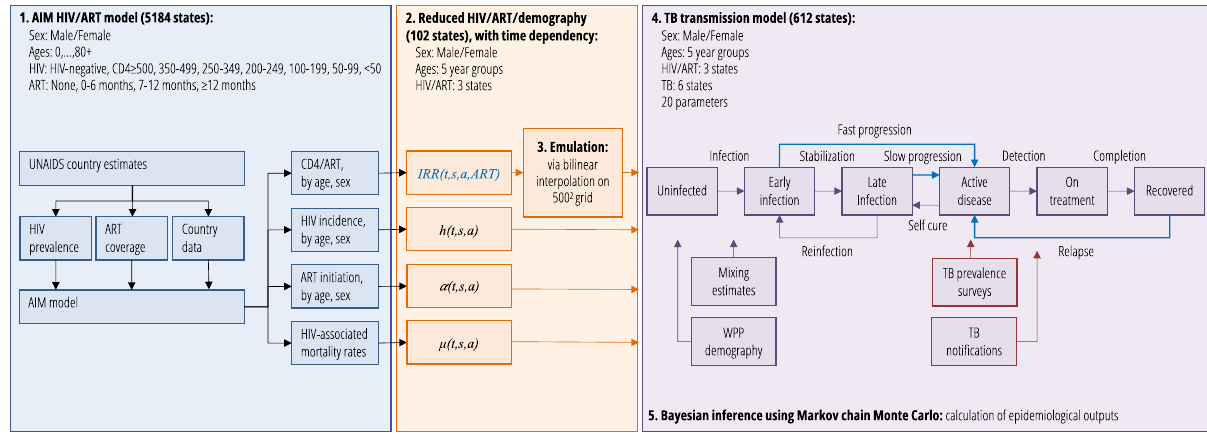
Fig.1|Process fl owandmodeldiagram. BluelinesfortheTBtransmissionmodel in step 4 are processes to which HIV/ART-associated incidence rate ratios IRR(t,s,a,ART) are applied. These time-dependent IRRs (step 2) capture the impli- cations of the AIM model of HIV/ART progression (step 1) for TB risk for each aggregated age, sex, and HIV/ART stratum in the simpli fi ed transmission